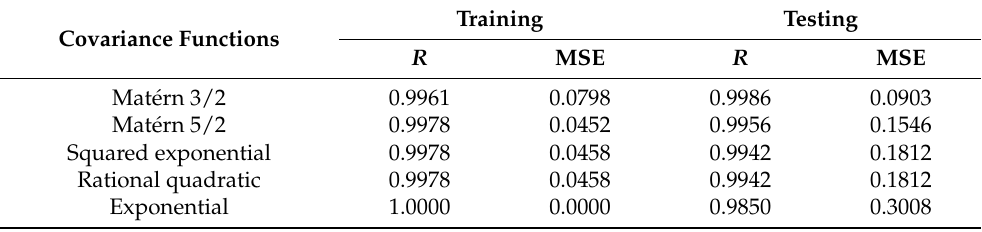
Table 6. Results of the Five different GPR Models.